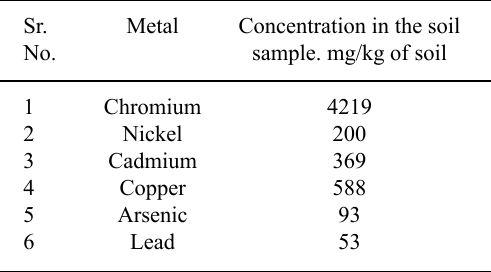
Table 1. Soil characterization for metallic